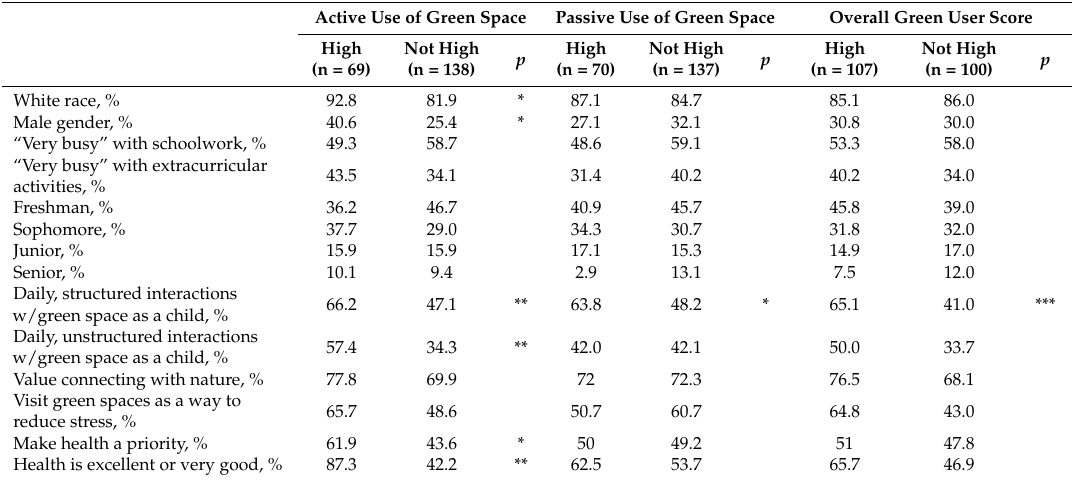
Table 1. Characteristics of the study population according to High versus Not High Active Use of Green Space, Passive use of Green Space, and Overall Green User Score (n = 207). Active Use of Green Space Passive Use of Green Space Overall Green User Score